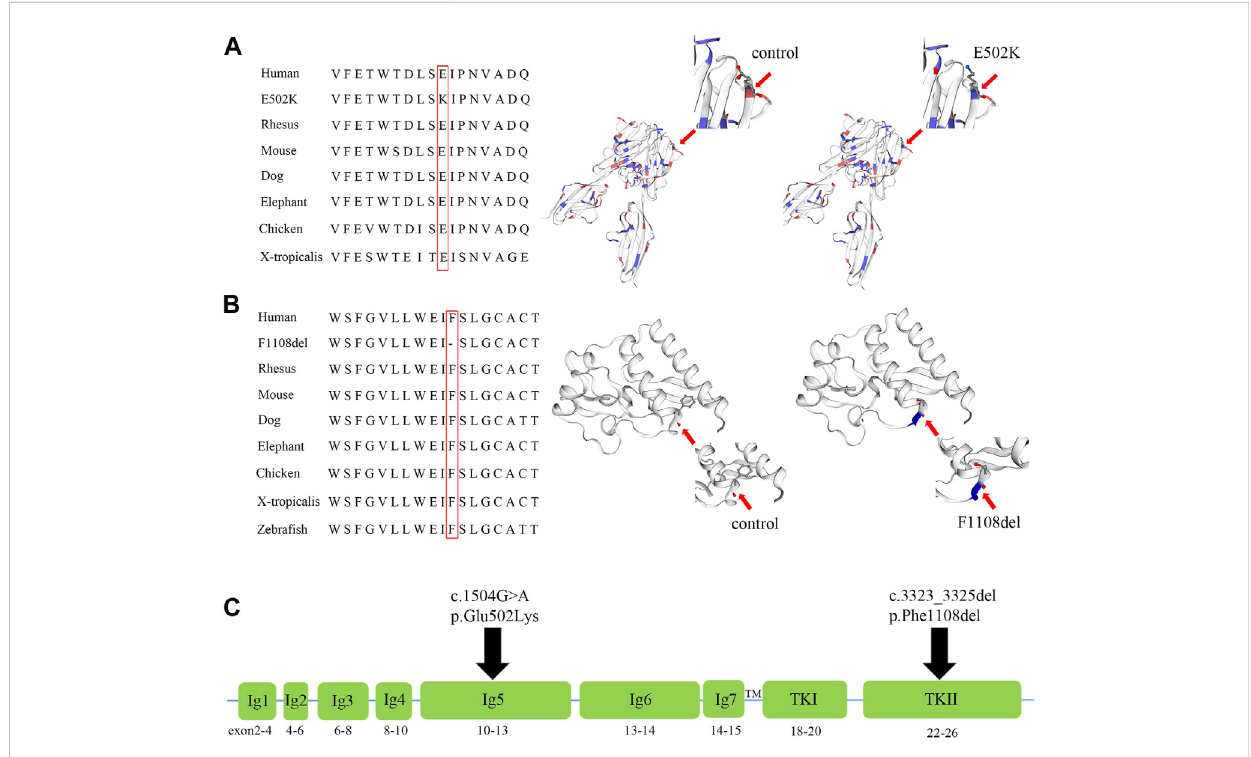
FIGURE 4 Amino acid alignment and prediction of the protein conformational changes of p.F1108del and p.E502K of the FLT4 gene, and the diagram of the FLT4 protein. (A) Multiplesequence alignment ofthe FLT4 homeodomainfromdifferentspeciesofvertebratesandX-tropicalisshowingtheevolutionary conservation of the glutamic residue at position 502 (highlighted in red box), and models of the wild-type and mutant E502K homeodomains of FLT4 wereconstructedwithSWISS-MODEL. (B) Multiplesequencealignmentofthe FLT4 homeodomainfromdifferentspeciesofvertebrates,X-tropicalis andZebra fi shshowingtheevolutionary conservationofthephenylalanineacidatposition1,108(highlightedinredbox), andmodelsofthewild-type and mutant F1108del homeodomains of FLT4 were constructed with SWISS-MODEL. (C) Diagram ofthe FLT4 proteinshowing the functional domains (Ig1 to Ig7 domains and TKI, TKII), and the location of p. E502K and